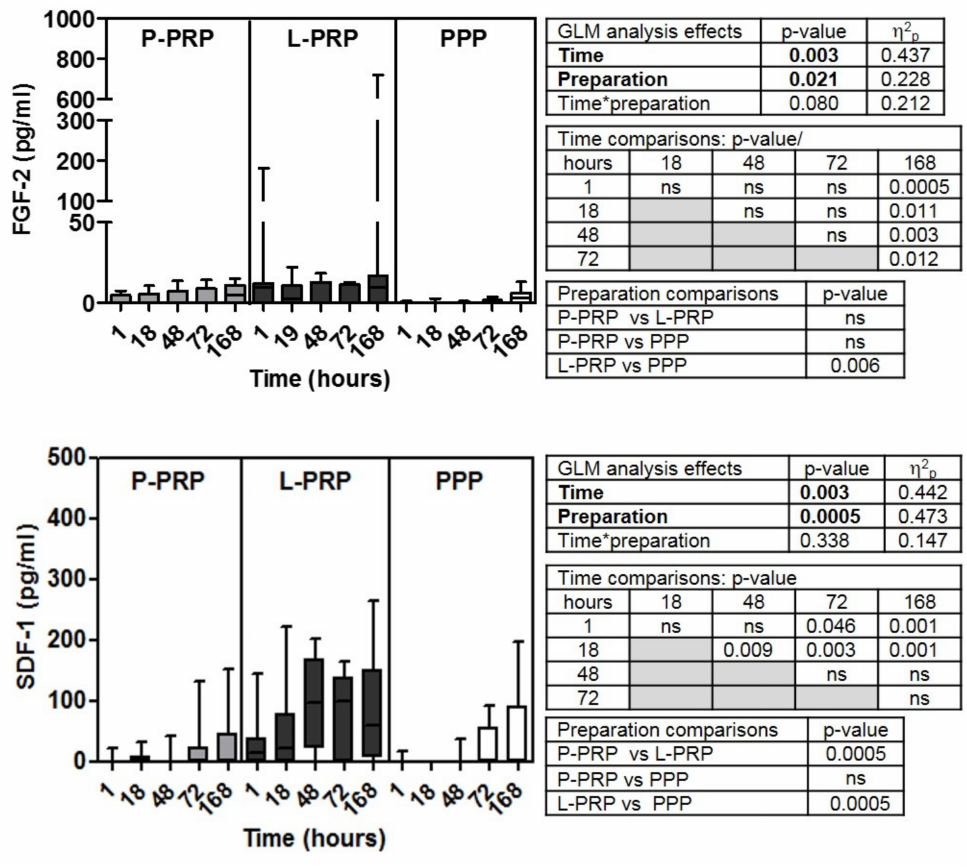
Figure 1. Concentrations of FGF-2 and SDF-1/CXCL-12 molecules in P-PRP, L-PRP, and PPP. Results are reported as medians (bars), 25th and 75th percentiles (boxes), and minimum to maximum values (whiskers); p value significances are reported in tables on the right side of each graph, as determined by general linear mode statistical analysis (bold); * variable association; ns, not